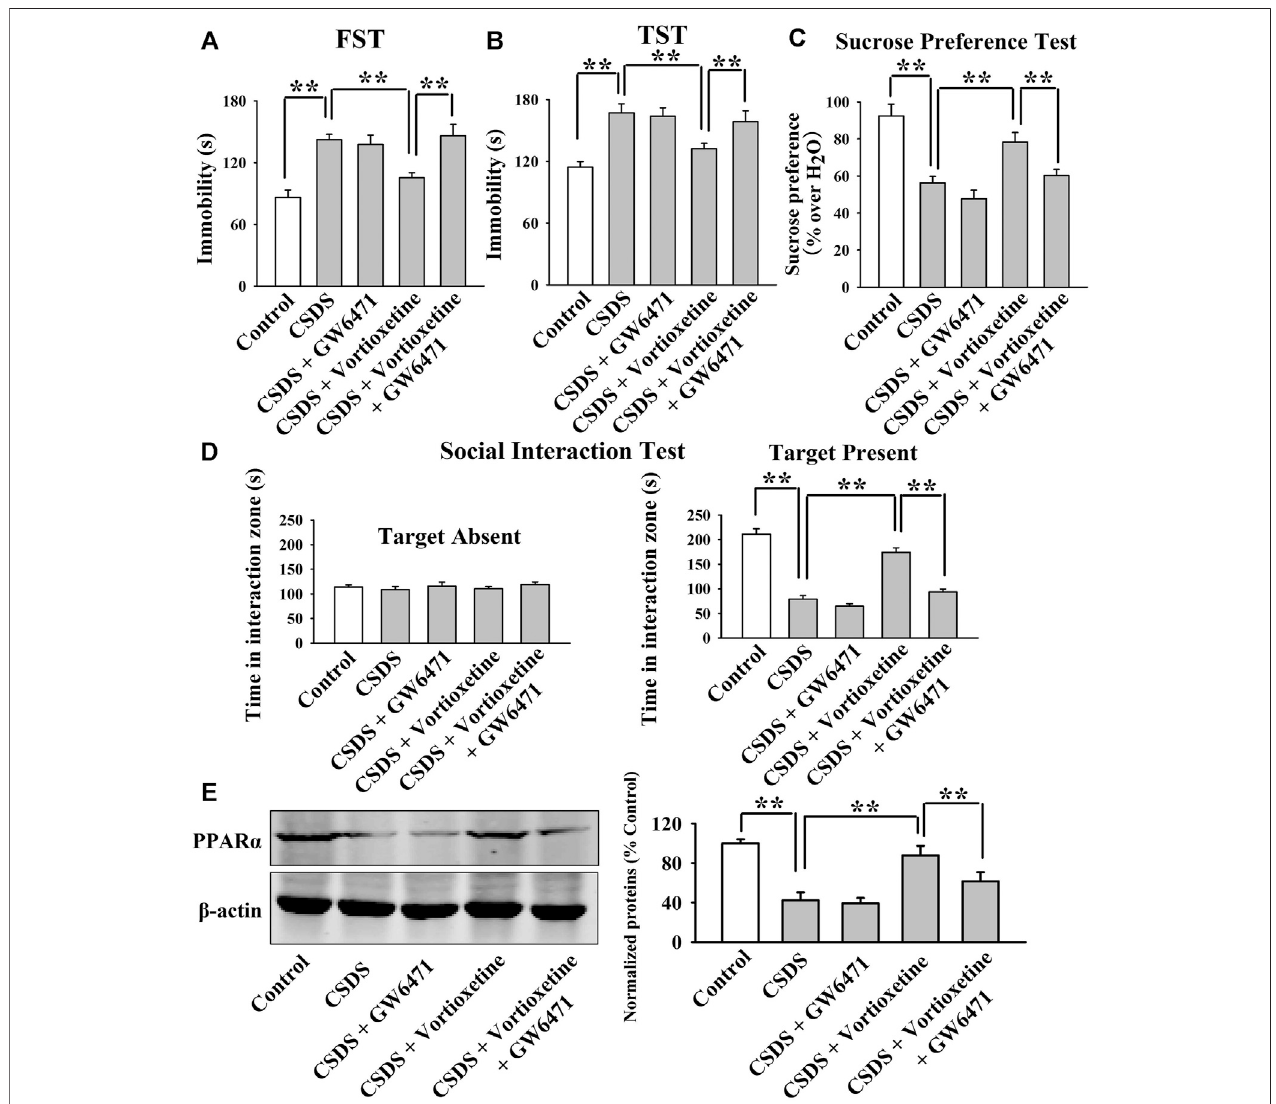
FIGURE 4 | The antidepressant actions of vortioxetine in the CSDS model were fully blocked by GW6471 co-administration. (A – D) The reversal effects of vortioxetine onthe CSDS-induced depressive-like behaviorsin mice were fullyblockedbyGW6471 co-administration, asrevealed bythe FST, TST, sucrose preference test and social interaction test. (E) Representative images and quantitative analyses indicate that the use of GW6471 notably prevented the promoting effects of vortioxetine on the hippocampal PPAR α expression in the CSDS-exposed mice. For (A – D) , n (cid:2) 10 per group; For (E) , n (cid:2) 5 per group. The data are expressed as the means ± S.E.M.; ** p < 0.01. The comparisons were made by two-way ANOVA followed by Bonferroni ’ s test.